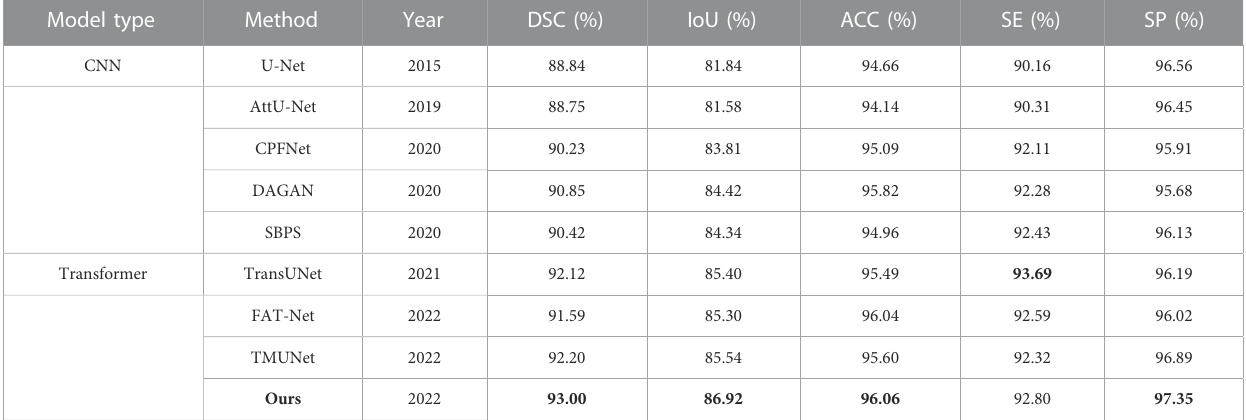
TABLE 6 Statistical comparison of the segmentation results on ISIC 2016. The best results are shown in bold. Model